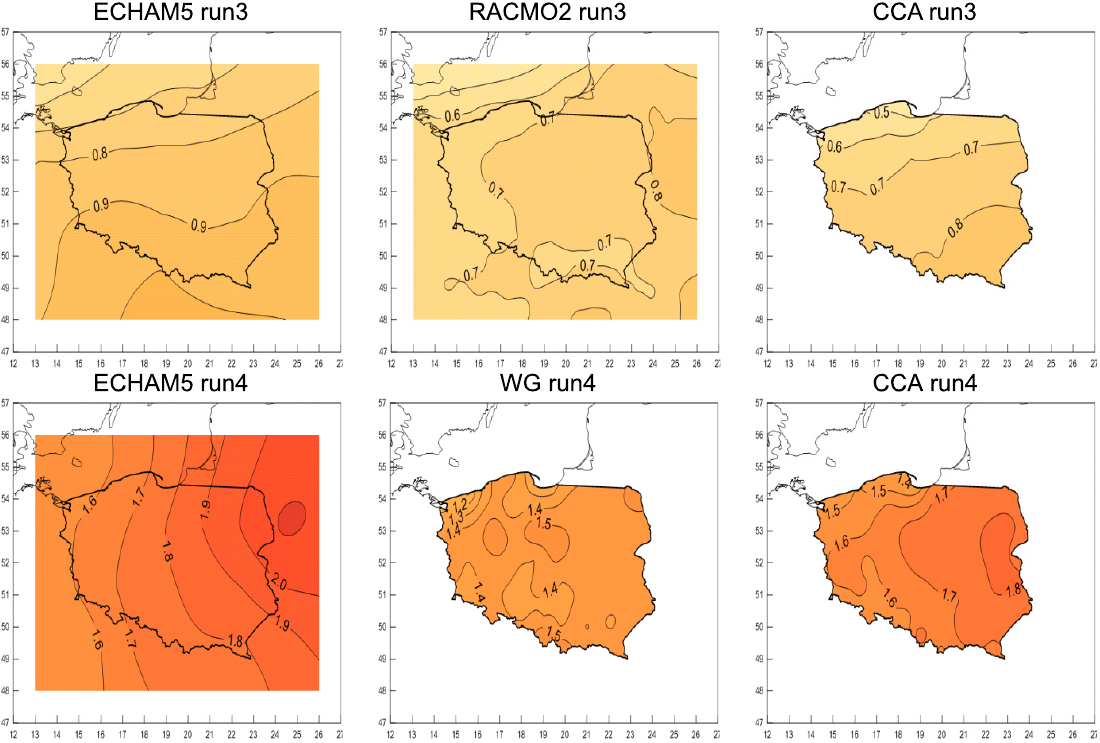
Fig. 8. Anomalies of air temperature (°C) in the autumn season (SON) 2011–2030 in relation to reference period (1971–2000) in Poland based on A1B emission scenario for models: ECHAM5 run 3and 4, RACMO2 run 3, CCA run 3 and 4, WG run